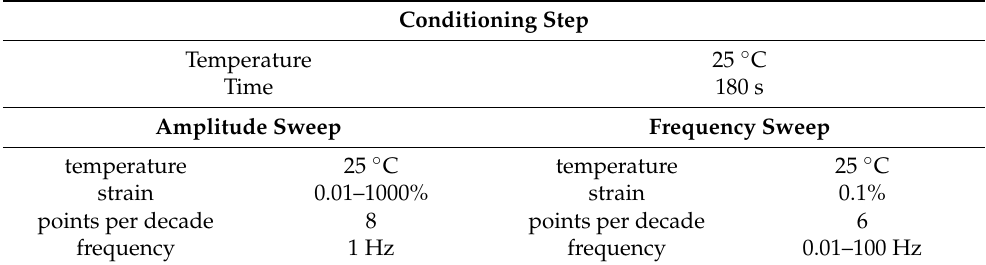
Table 11. Summary of settings for rheology measurements (conditioning step, amplitude sweep, and frequency